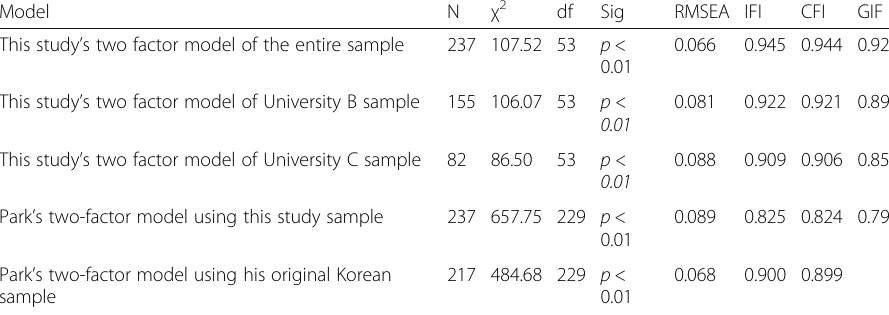
Table 7 Results of confirmatory factor analysis ( n = 237): Goodness-of-fit indices of the two-factor model for the FLCAS